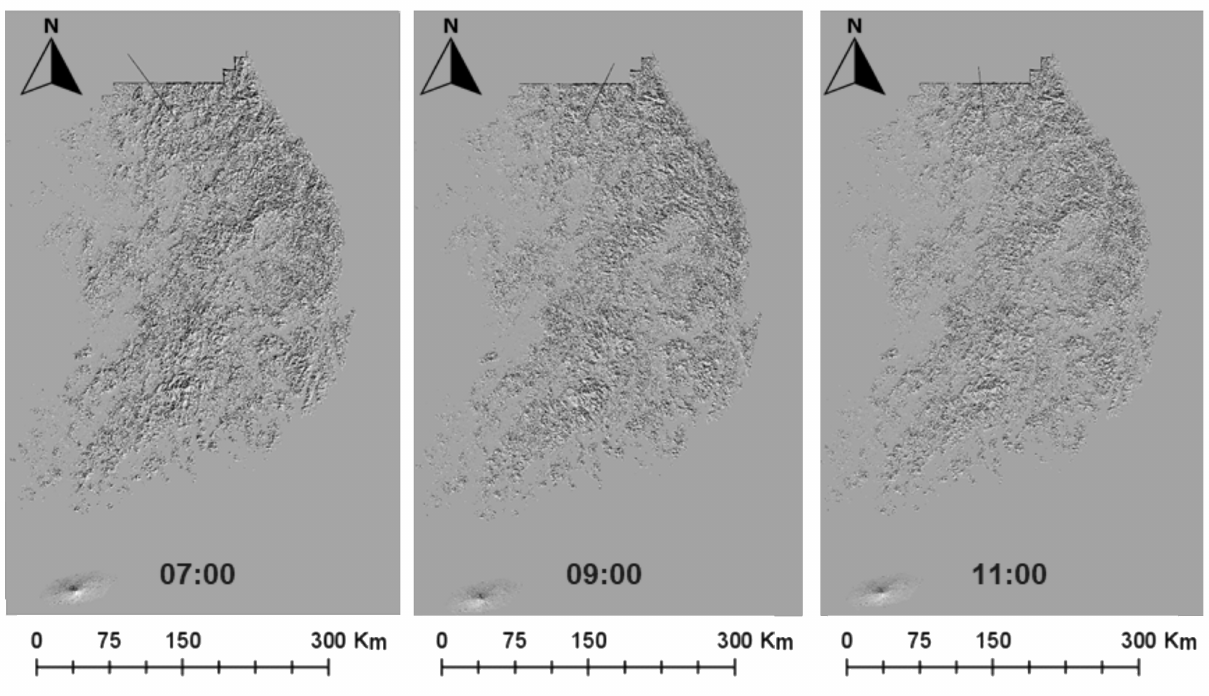
Figure 4. Hillshade simulation with 3D spatial